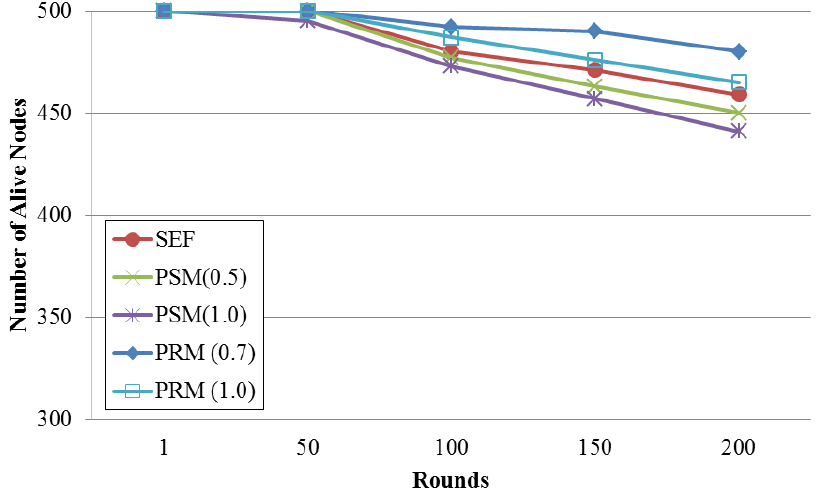
Figure 5. Number of alive node by elapsed time with the security value (α) in case that the number of forged MAC is